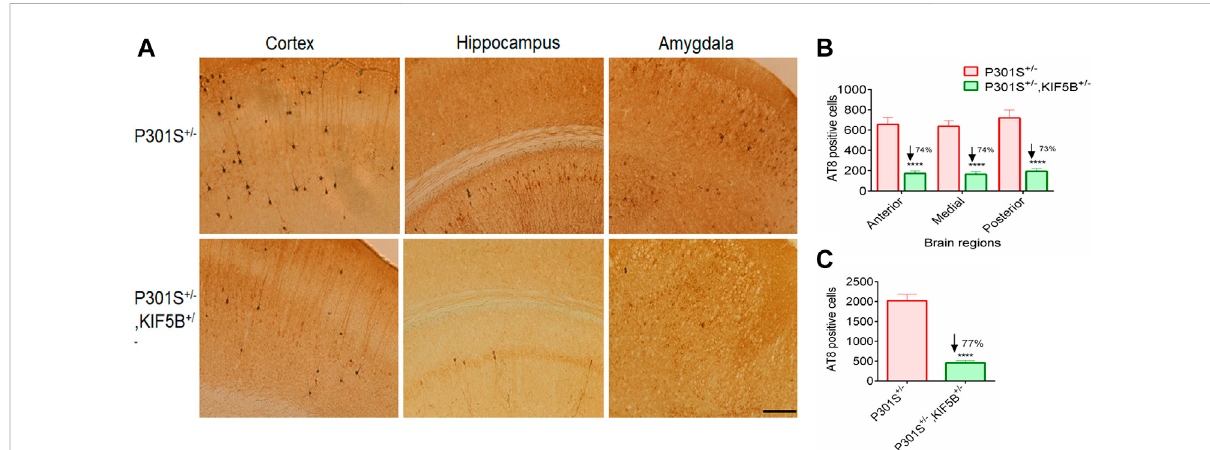
FIGURE 7 Decreased AT8-positive tau pathology in the brain of KIF5B reduction combined with P301S Tau. (A) Immunostaining of AT8 tau in the coronal brain section of P301S +/ − and P301S +/ − ,KIF5B +/ − (B,C) Reduction of area-wise and total count of AT8-positive neurons were shown for all overall half coronal hemisphere of P301S +/ − ,KIF5B +/ − mice. Values represent group mean ± SEM, and n = 14 mice per group. In (B) , *** p < 0.0001 vs. P301S +/ − after two-way ANOVA followed by Turkey post hoc analysis. In (C) , **** p < 0.0001 vs. P301S +/ − after one-way ANOVA followed by Turkey post hoc